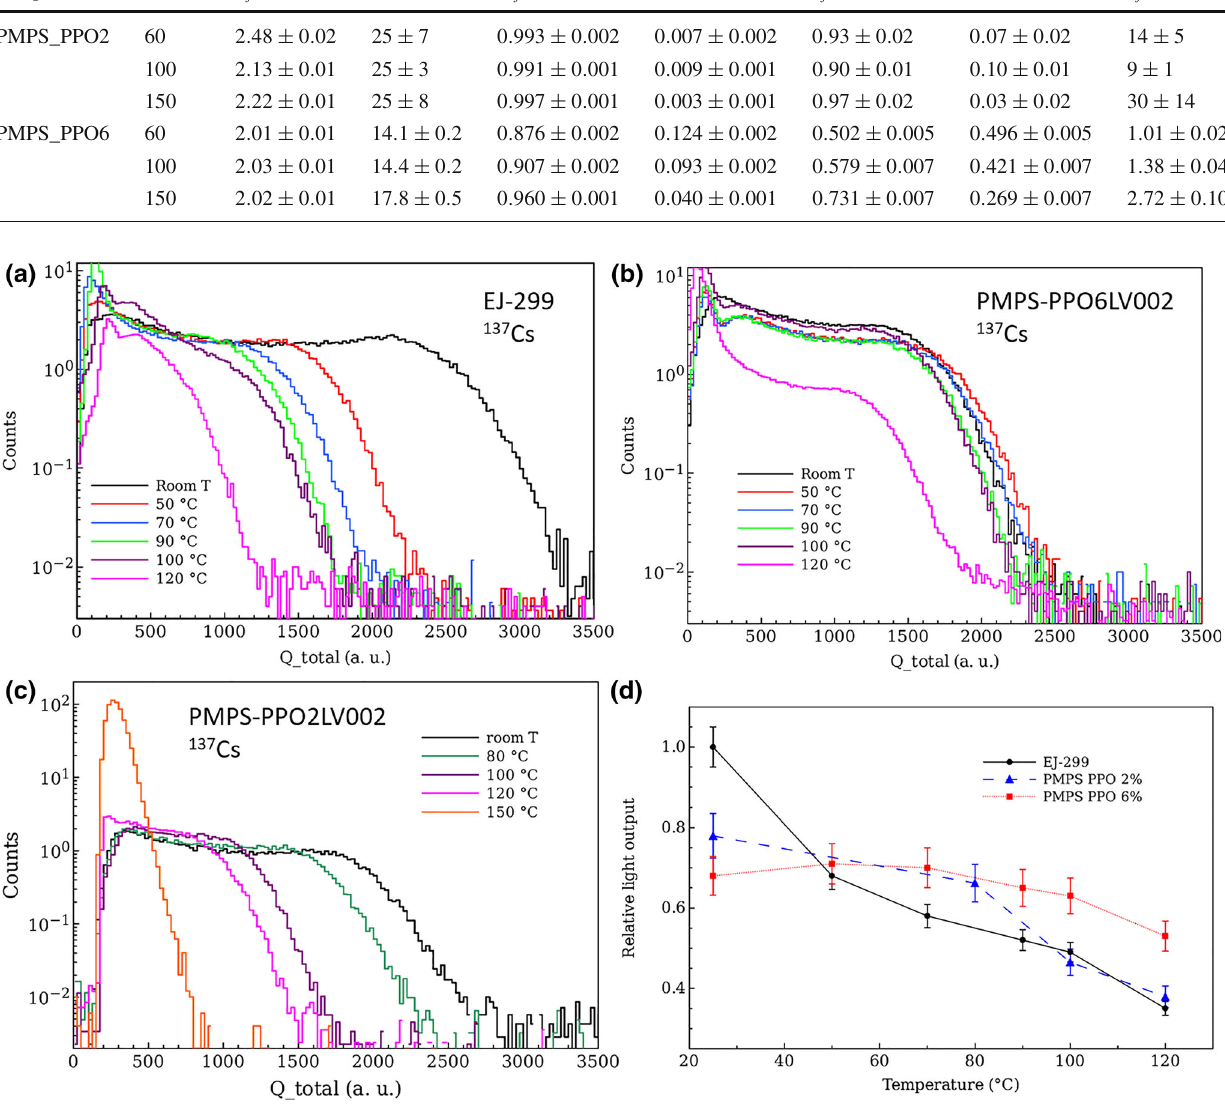
Fig. 6 Pulse height spectra collected by exposing the standard EJ-299 ( a ) and the siloxane-based scintillator with 6% PPO ( b ) and 2% PPO ( c ) to γ -rays from 137 Cs source. The LY as relative % of EJ-299 versus